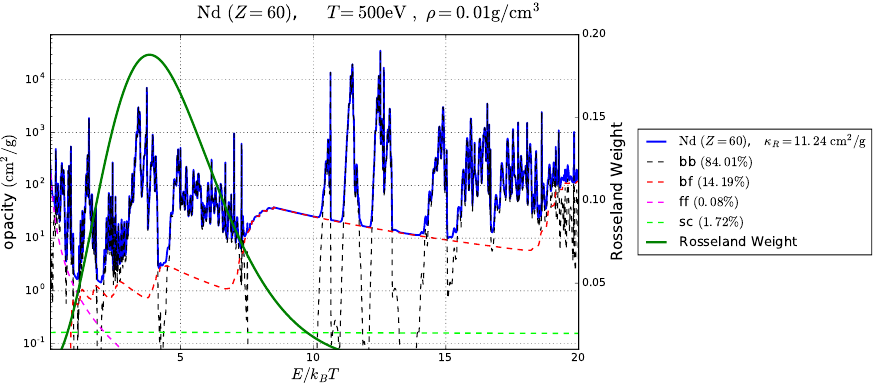
Figure 3. Same as Figure 2, for neodymium ( Z = 60) at T = 500 eV and ρ = 0.01 g/cm 3 .